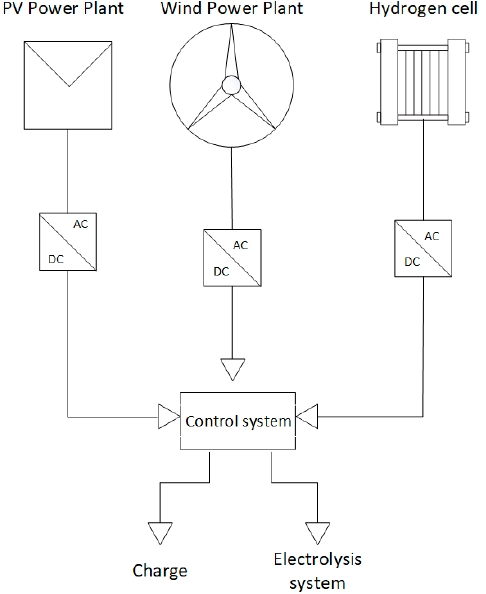
Figure 2. Schematic layout of the hybrid energy generation system.